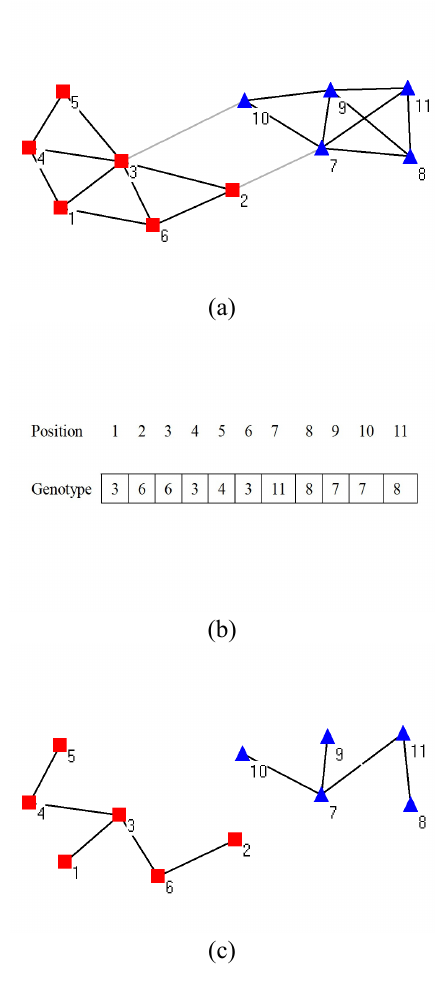
Fig. 1. (Color online) An illustration for the locus-based adjacency representation. (a) A sample network consisting